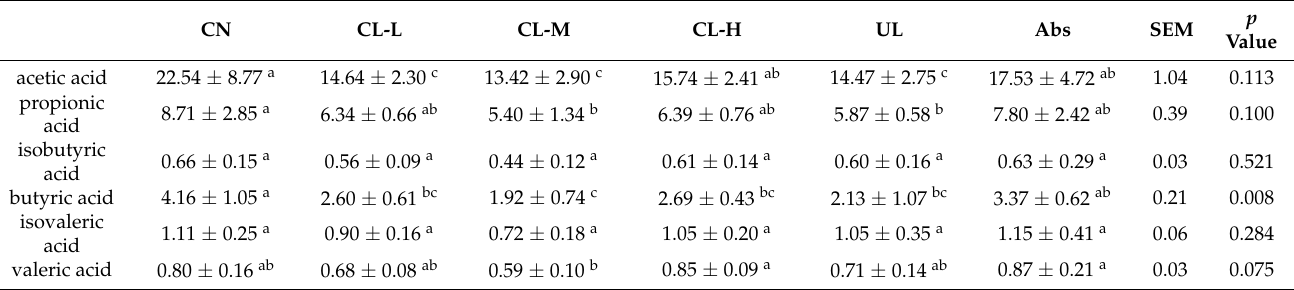
Table 3. Determination of short-chain fatty acid concentrations